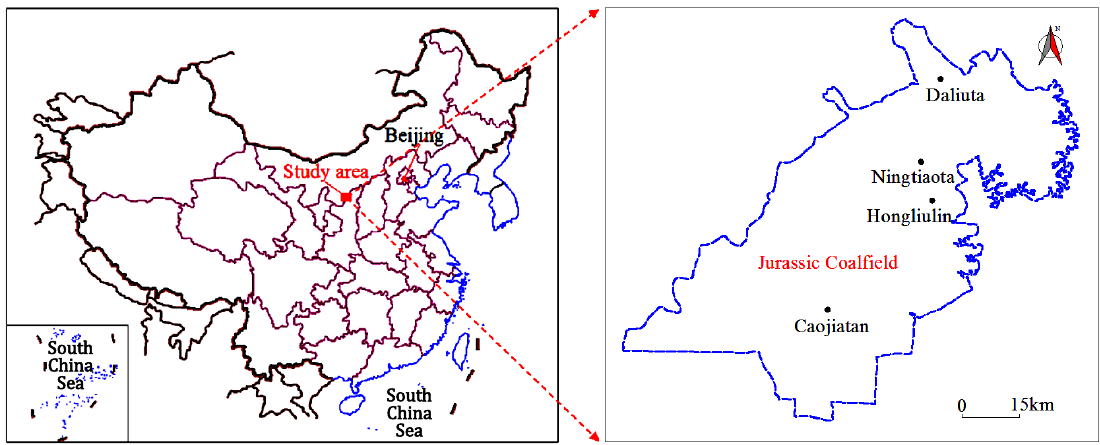
Figure 1. The location of Jurassic Coalfield in China.